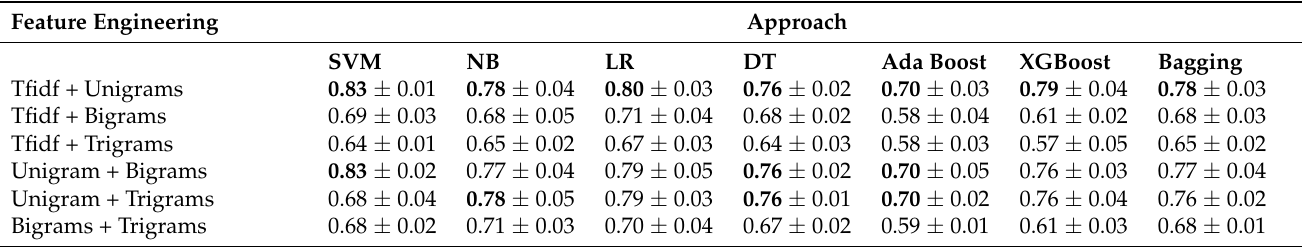
Table 5. Accuracy comparison of proposed models. Most significant results are in bold.